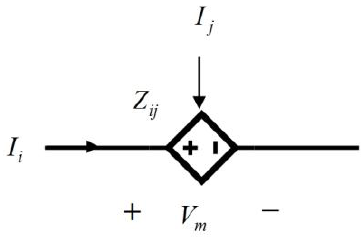
Figure 5. Current-controlled voltage source.